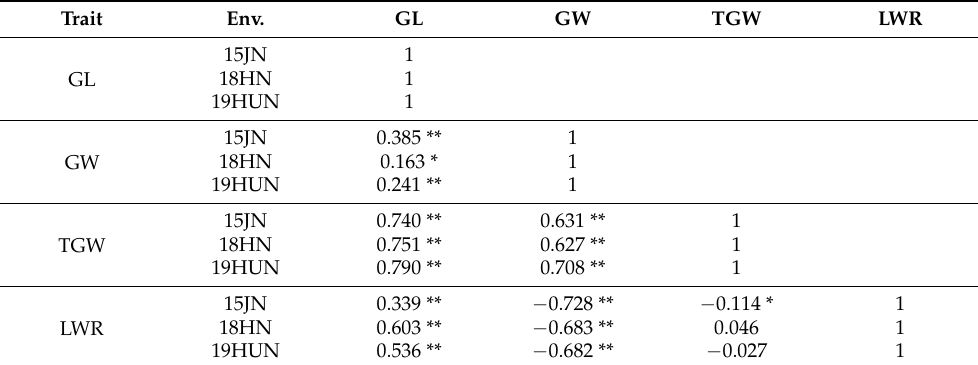
Table 2. Phenotypic correlation between four grain traits (GL, GW, TGW, and LWR) of the F 2:3 populations across three environments. Trait Env. GL GW TGW LWR 15JN GL